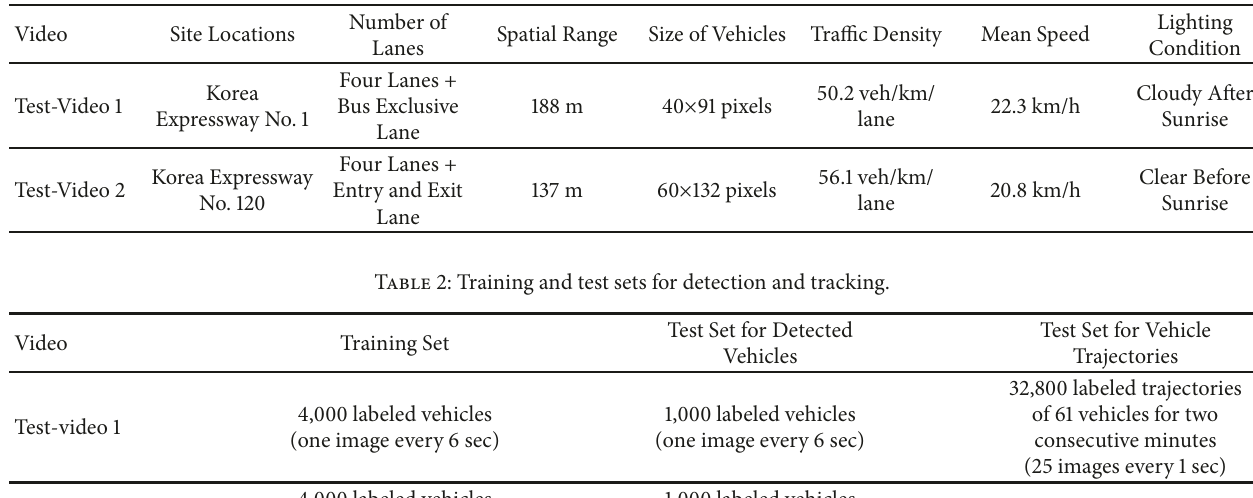
Table 1: Description of video datasets.